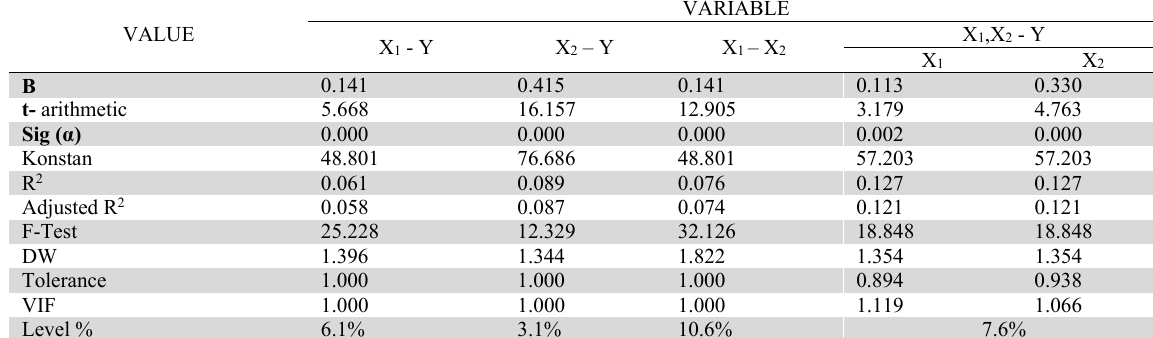
The results of statistical calculations of research data